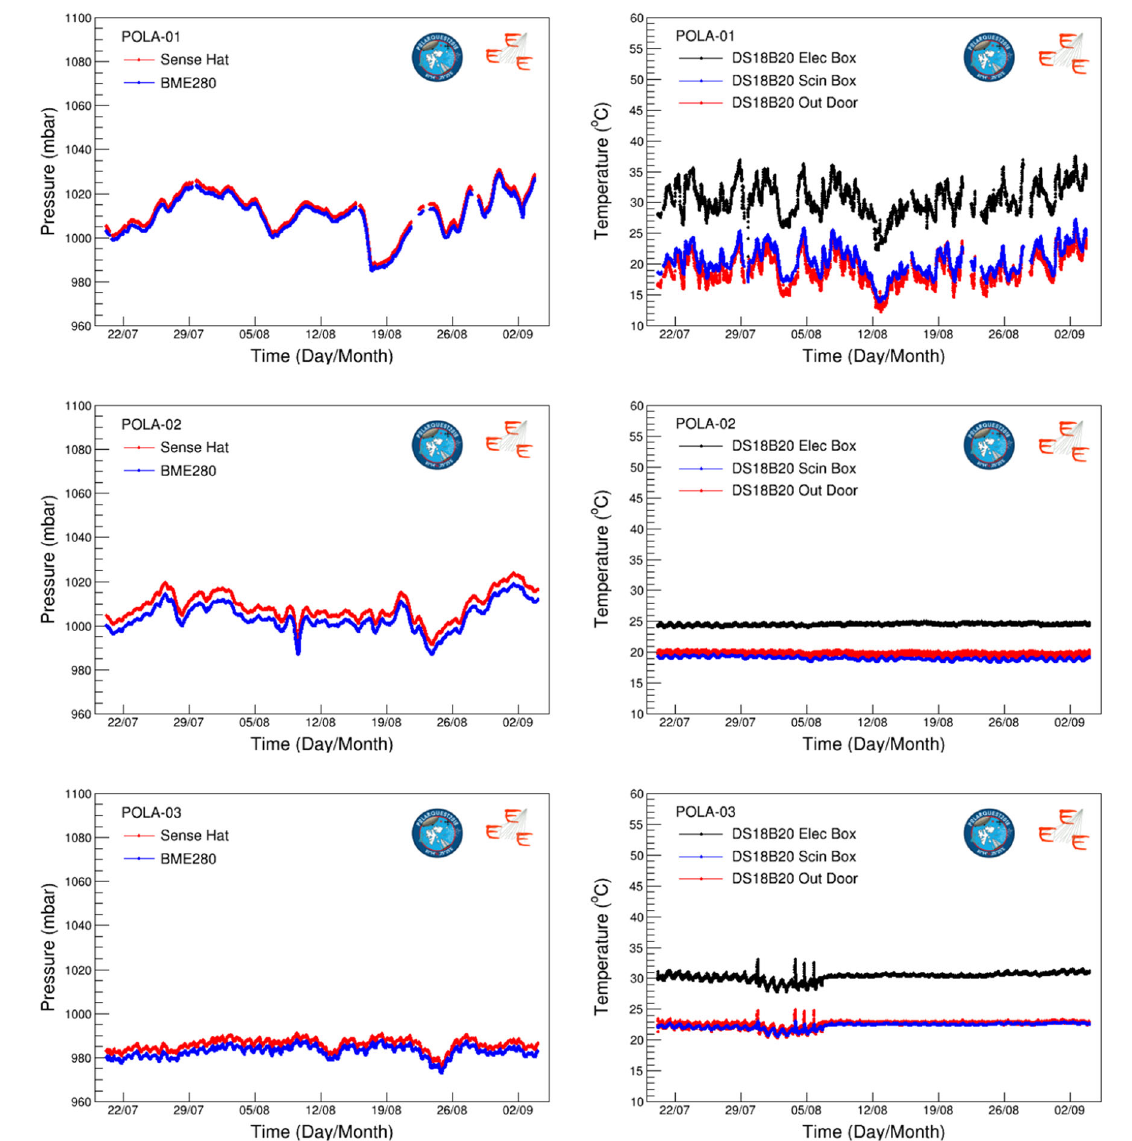
Fig. 11 Pressure (left) and temperature (right) as a function of the time, from July 21, 2018 up to September 4, 2018, measured by the sensors of the three POLA detectors: from top to bottom, results from the sensors of POLA-01, POLA-02 and POLA-03